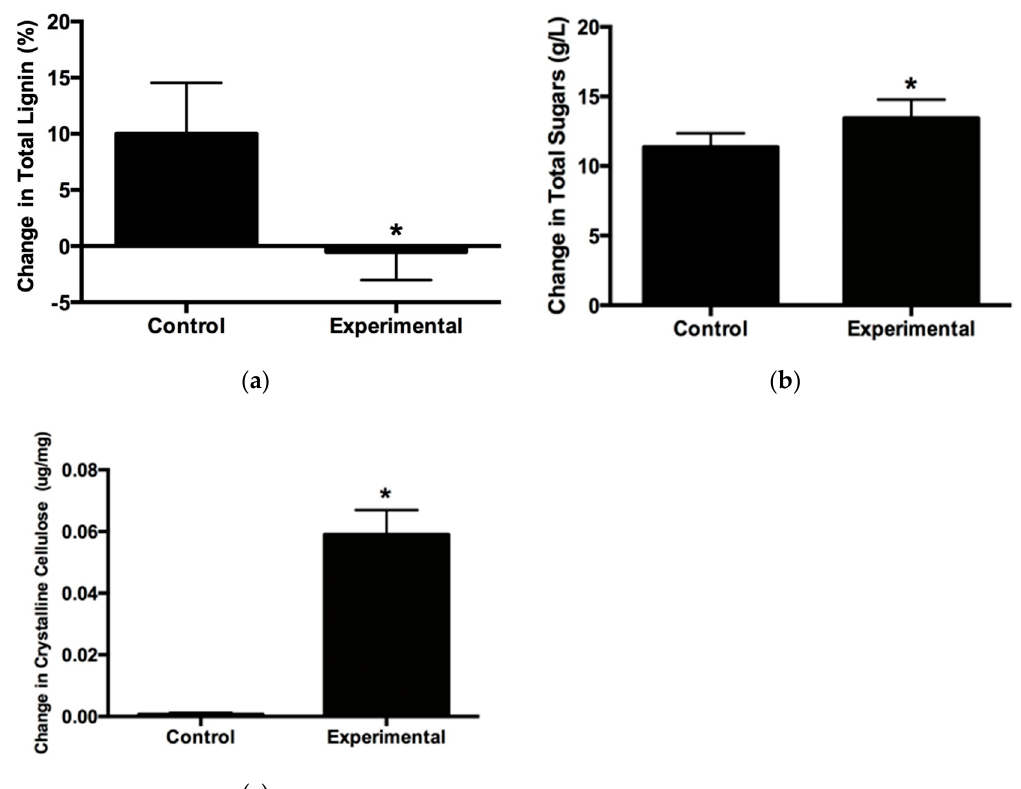
Figure 3. Changes in the lignocellulosic composition of vetiver biomass grown in control (control) soil and stamp sand (experimental) soil over 60 days: ( a ) percent changes in total lignin, ( b ) changes in total hemicellulose (sugar) levels in g/L, and ( c ) changes in crystalline cellulose in μ g/mg. Error bars show standard deviation (n = 6). (*) indicates p -value = < 0.05, using t -test with Welch’s correction and α = 0.05.